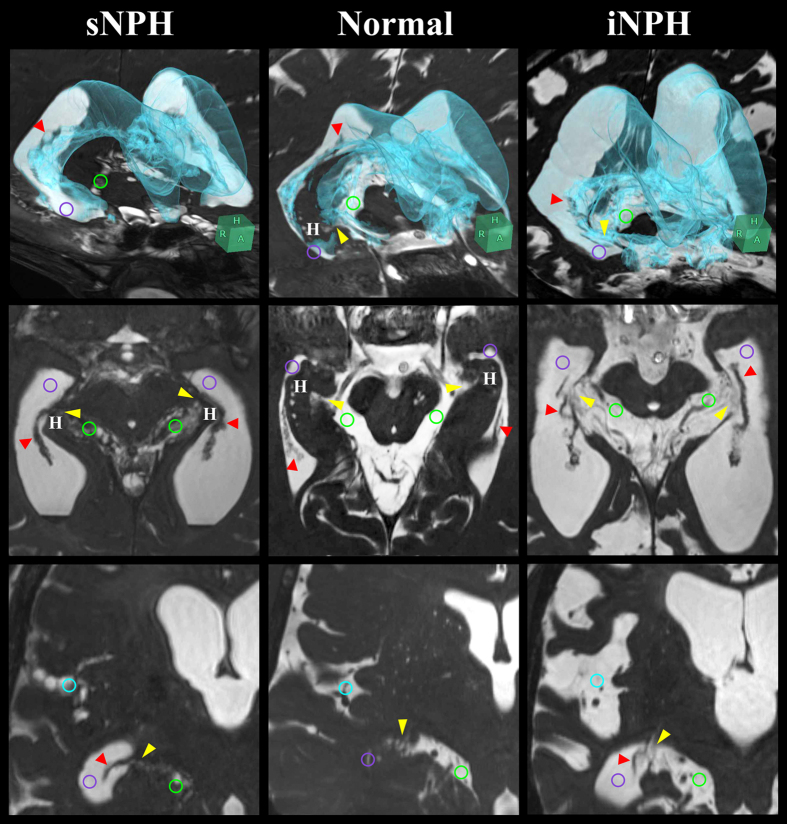
Fine structures of the lateral ventricles and the basal cistern around the inferior choroidal point of the choroidal fissure.The 3D views (upper) which combine axial (middle) and coronal (lower) sections were at the level of the inferior choroidal point of the choroidal fissure (yellow arrow head) between the ambient cistern (light green circle) and the inferior horn of the lateral ventricles (purple circle). In the normal situation, at the head of the hippocampus (H) and choroid plexus (red arrow head), the ambient cistern is separated from the inferior horn of the lateral ventricles. In patients with iNPH, the ventricles, basal cistern and Sylvian fissure (light blue circle) were enlarged with the concurrent opening of the inferior choroidal point of the choroidal fissure. However, in patients with sNPH, only the ventricle was enlarged and all of the subarachnoid spaces, including the ambient cistern and Sylvian fissure, were severely diminished.